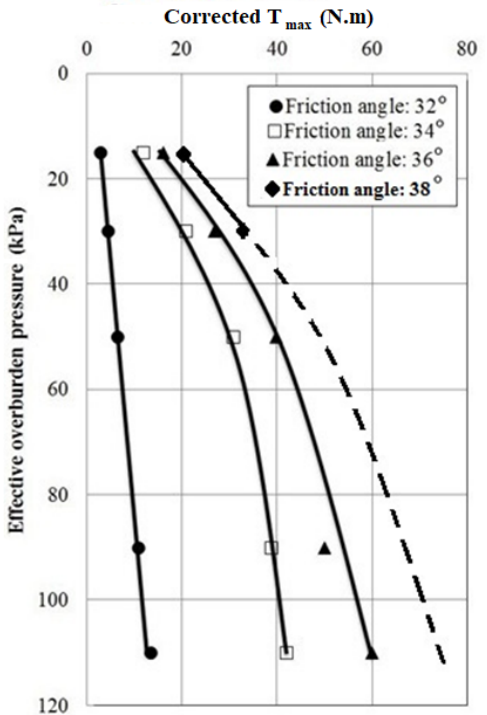
Figure 11. Relationship between the corrected T max , effective overburden pressure and friction angle.